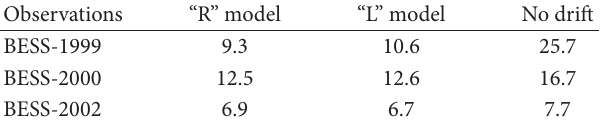
(in percentage, ), for BESS-1999, BESS- T 8: Average rms (in percentage, 2000, and BESS-2002 obtained from (17) without enhancement of rms and , for BESS-1999, BESS- ), the diffusion tensor along the polar direction ( % 𝜂𝜂 𝜂𝜂 , and using “R” and “L” models for the tilt ), using “R” angle and No Dri approximation. e differential intensities were 𝜌𝜌 𝐸𝐸 = 1 calculated accounting for particles inside the heliospheric regions 𝜌𝜌 𝐸𝐸 = 1 for which solar latitudes are lower than |5.7